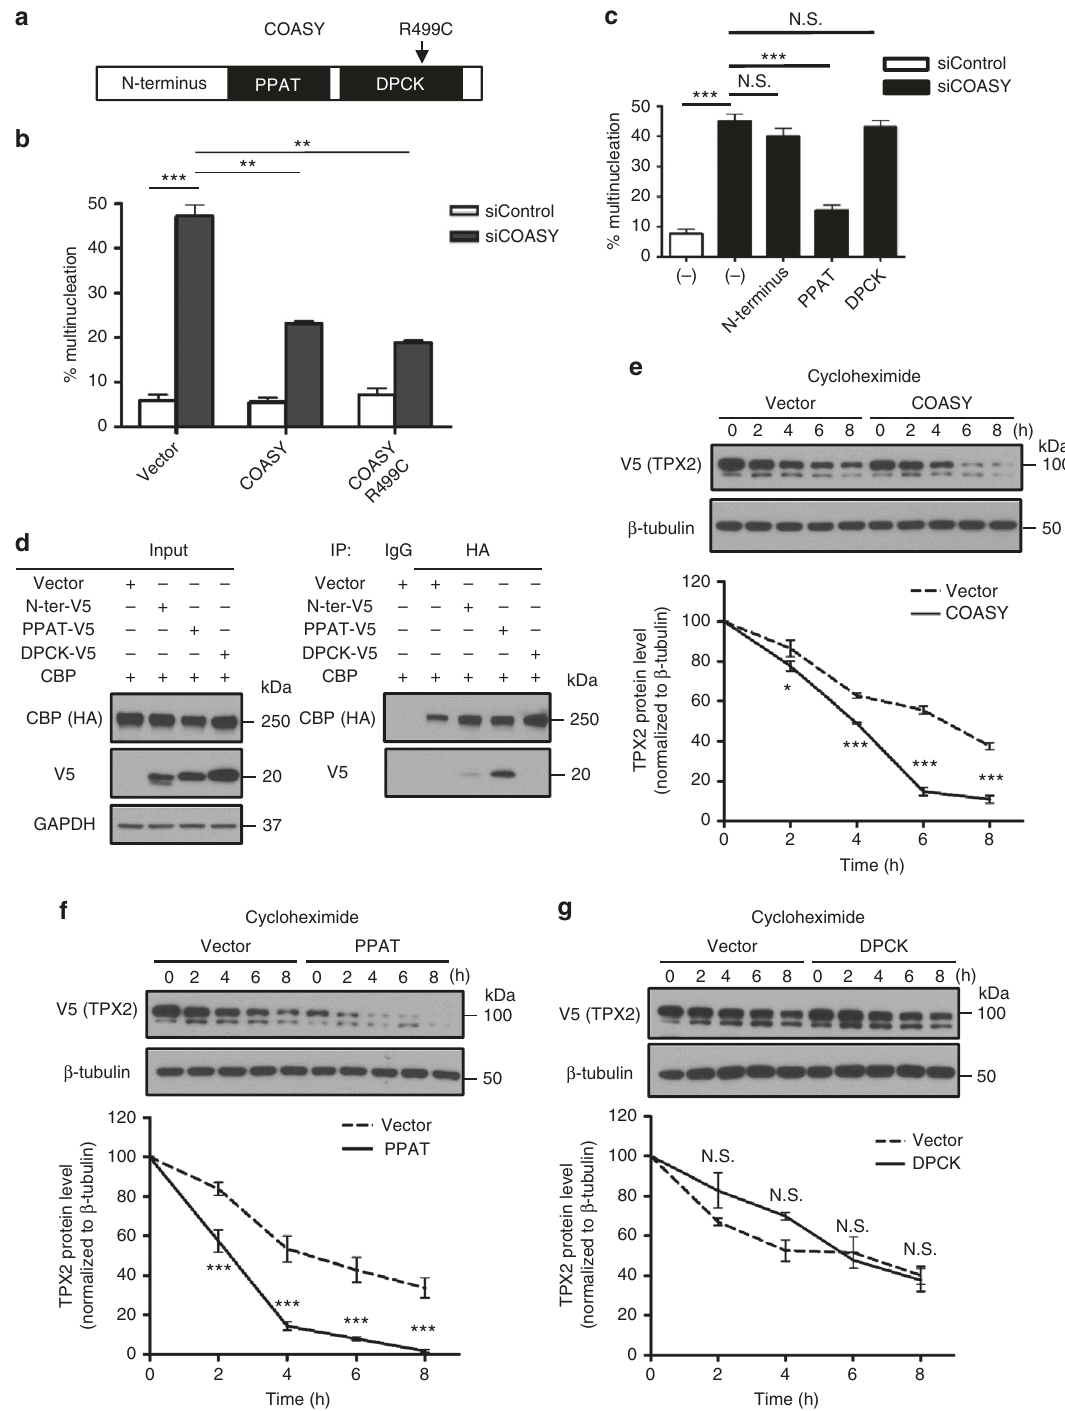
Fig. 6 PPAT on COASY regulates TPX2 protein stability by interacting with CBP. a Schematic illustration of domains on COASY. COASY is composed of N terminus regulatory domain and two catalytic domain (PPAT and DPCK). R499C mutant inactivates DPCK. b Both wild and R499C of COASY cDNAs rescued multinucleation. MDA-MB-231 cells stably expressing control vector (pLKO.1), wild type or R499C COASY were transfected with COASY siRNA for 72 h. The multinucleation induced by COASY siRNA can be abolished by both wild type and R499C COASY. c Overexpression of PPAT rescued the multinucleation induced by COASY knockdown. * p < 0.05, ** p < 0.01, two-tailed Student ’ s t -test, n = 3 independent repeats. d PPAT and CBP showed strong interaction. The cDNA of N-terminus domain, PPAT or DPCK were cotransfected with CBP cDNA to HEK-293T cells. The cells were then enriched in mitosis by nocodazole treatment and harvested for co-immunoprecipitation. e – g Both COASY and PPAT, but not DPCK, promote the degradation of TPX2 protein. COASY ( e ), PPAT domain ( f ), DPCK domain ( g ) was cotransfected with CBP and V5-tagged TPX2 into unsynchronized HEK-293T cells. After 24 h, the protein synthesis of the transfected cells was halted with 25 mg/ml cycloheximide and collected at the indicated times for western blots. The TPX2 protein level at indicated time points was quanti fi ed by Image J software and normalized to b-tubulin protein level. b , c N.S. not signi fi cant *** p < 0.001, ** p < 0.01, two-tailed Student ’ s t -test, n = 3 independent repeats. e – g Two-way ANOVA: p < 0.0001 ( e ), p < 0.0001 ( f ), N.S. ( g ). Bonferroni post hoc tests, * p < 0.05, *** p < 0.001, n = 3 independent repeats. Bars show standard error of the